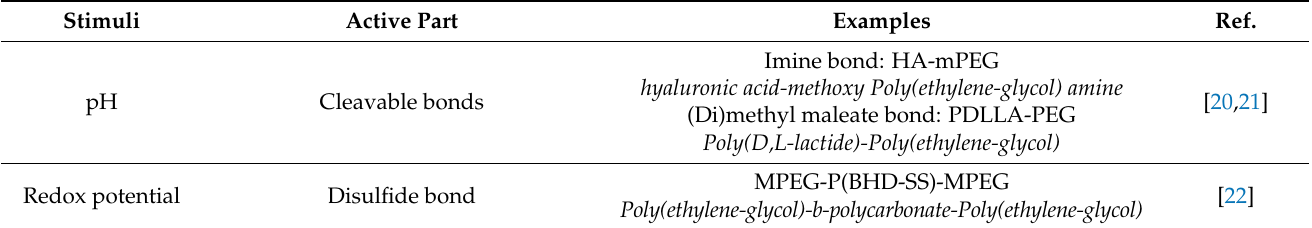
Table 1. Single stimuli-responsive polymers.